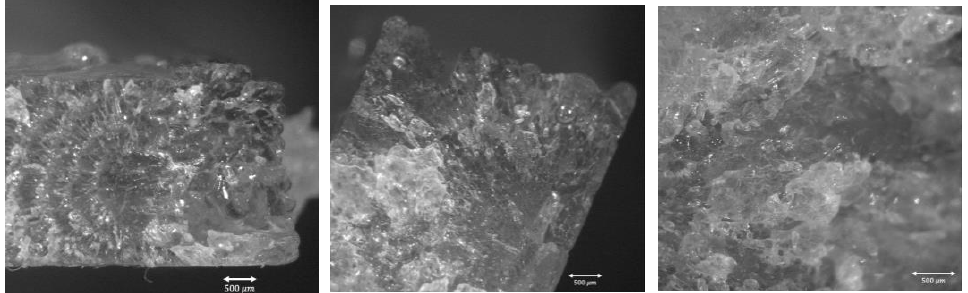
Figure 10. Fractured surface of the tested tensile samples.